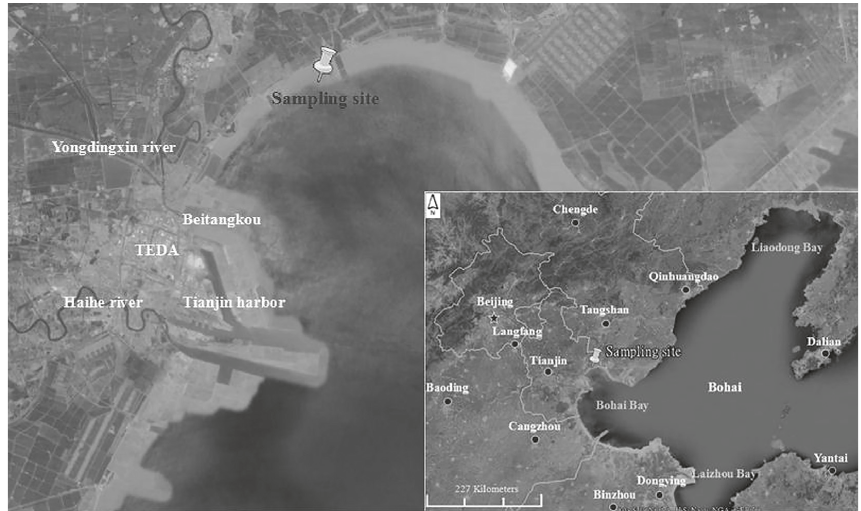
Figure 1: Geographic map of the sampling